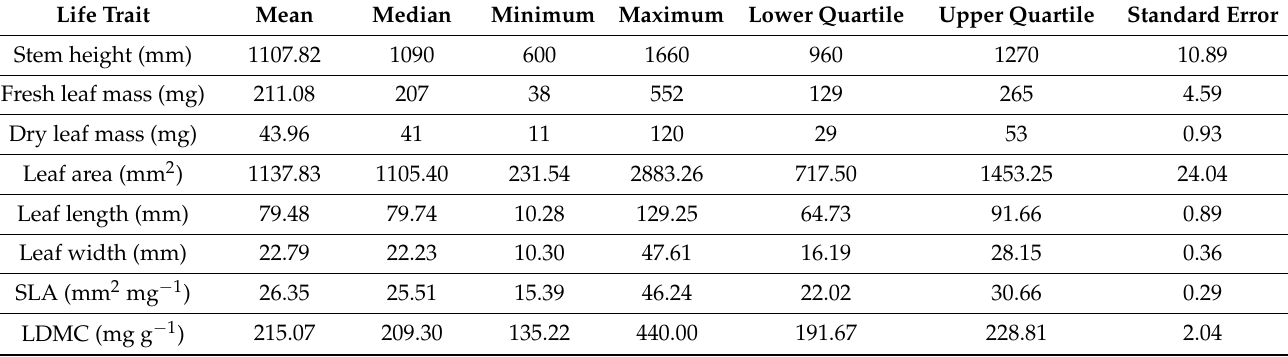
Table 2. Descriptive statistics of eight life traits for E. annuus for 87 individuals and 435